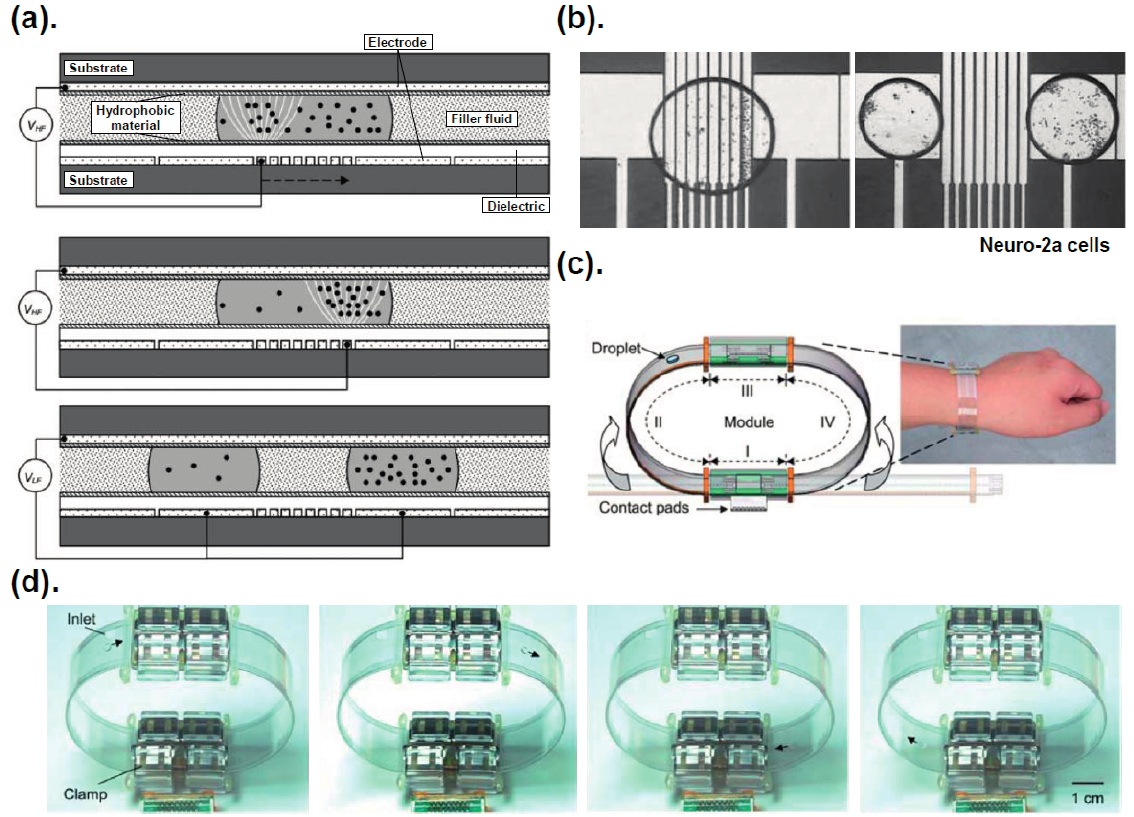
Figure 3. Dielectrophoresis (DEP) forces exerting on the suspended particles described by Fan et al. , 2008 [39]. ( a ) A parallel-plate device with square and strip electrodes to manipulate droplets and a particle; ( b ) DEP forces exerted on suspended particles including mammalian cells (Neuro-2a); ( c , d ) Prototype of EWOD-based, continuously microfluidic module for a portable system reported by Fan et al. , 2011 [70]. Reproduction of the figures has been made with permission from The Royal Society of